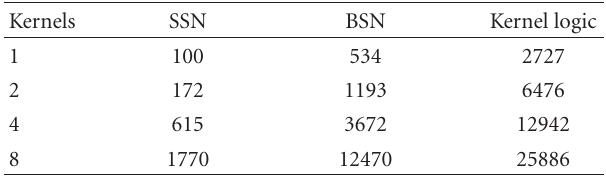
Table 8: Redsharc system LUT